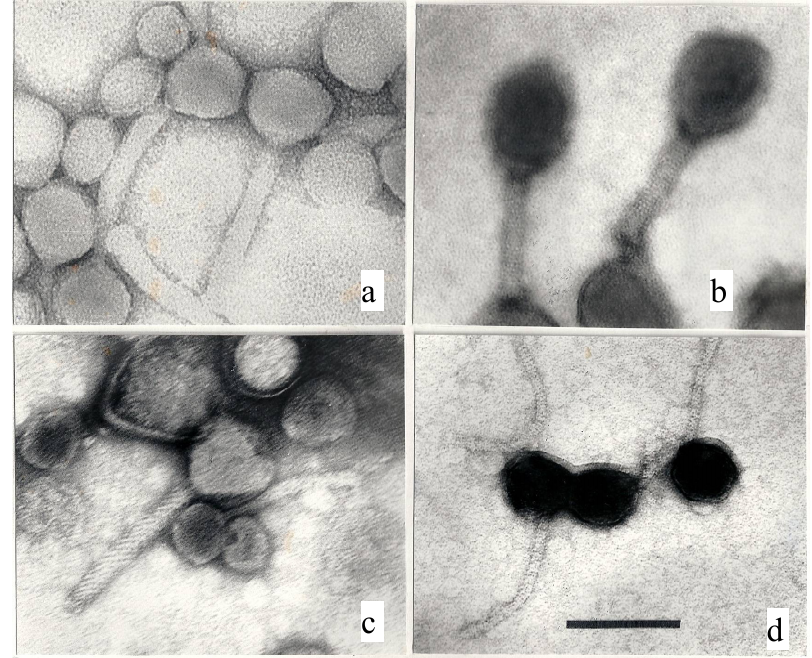
Figure 1. A rogue gallery of poor electron micrographs. ( a ) A contreastless image of a Pseudomonas myovirus; ( b ) Underfocused, unsharp image of two T4-like phages. ( c ) Underfocused, unsharp and astigmatic picture of a Pseudomonas myovirus, a siphovirus, and various cell debris; ( d ) Positive staining in a T5-like coliphage; note the apparent absence of edges and facets on the phage heads. 297,000×; uranyl acetate; the bar indicates 100